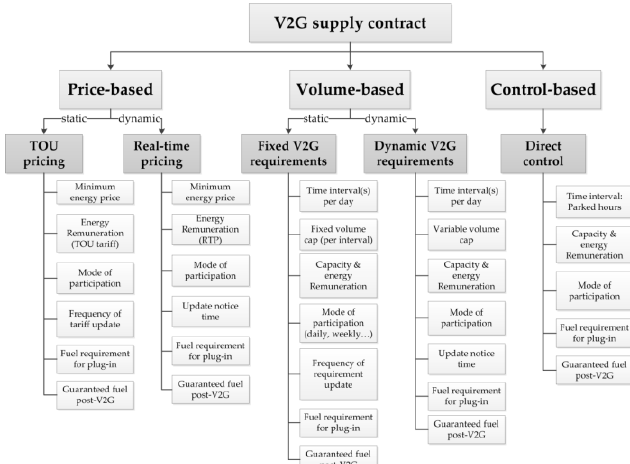
Figure 5 . Contract types and specifications for V2G